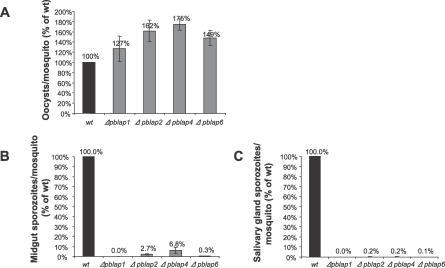
Oocyst and Sporozoite Development of wt and Δpblap ParasitesGraphical summary of oocyst numbers (A), midgut sporozoite numbers (B), and salivary gland sporozoite numbers (C) of wt and Δpblap parasites. Values of Δpblap parasites are given as mean % of wt (± standard error of the mean). Δlap1 as published in [2]. Please refer to Tables S3 and S4 for individual data.